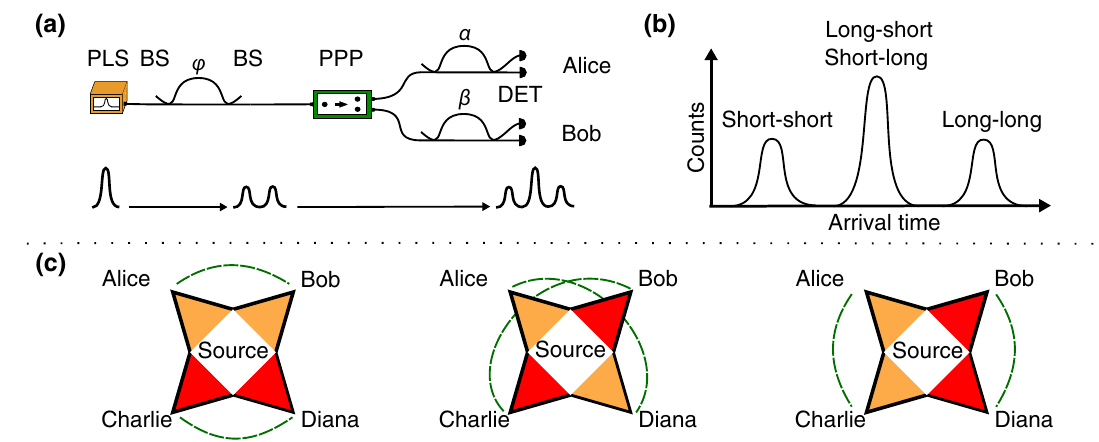
FIG. 1. (a) The scheme for time-bin entanglement quantum key distribution with the BBM92 protocol [36–38]: PLS, pulsed laser source; BS, 50:50 beam splitter; PPP, photon-pair production; DET, single-photon detector. The symbols φ , α , and β indicate the phase delay of the interferometers. (b) The arrival-time histogram at one of the detectors. Depending on the combination of long and short paths taken in the pump and receiver interferometers, the photons arrive in one of three time bins. Detection events in the early (short-short) and late (long-long) peak yield detections in the time basis, while events in the central peak (long-short and short-long) yield detections in the phase basis. (c) The possible configurations in a four-participant star-shaped network with pairwise mutually exclusive combinations. For one given configuration, each participant is linked to exactly one other participant, so that two connected pairs can exchange keys simultaneously and independently. The dotted green lines indicate the communication over a classical channel, which is required in addition to the unidirectional quantum